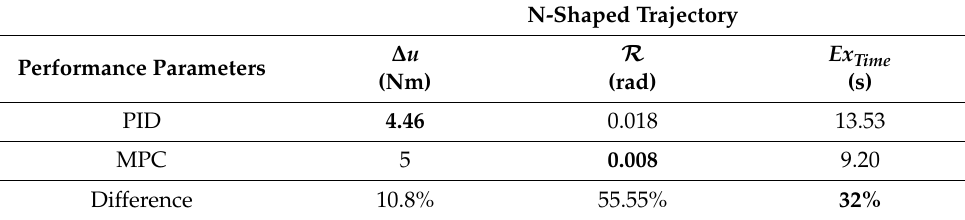
Table 7. Calculation of the performance parameters for N-shaped reference